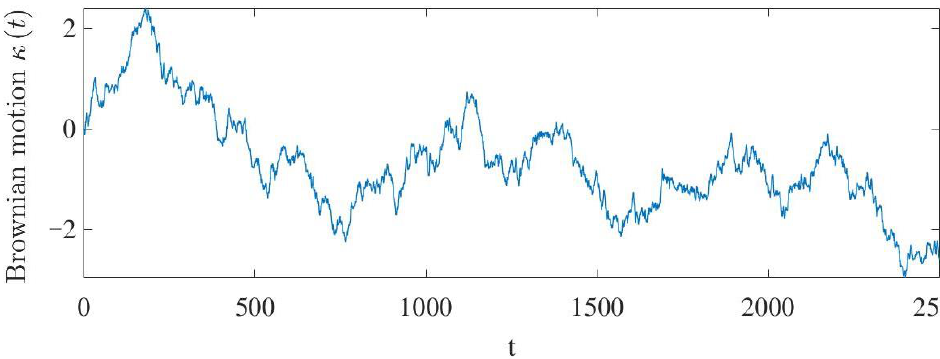
Figure 4. The Markov states of switching topology.